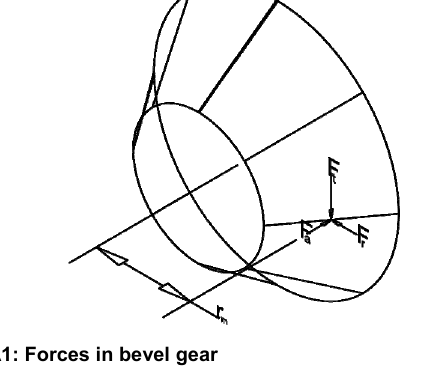
Case II: Right-hand helix and CCW rotation or Left- hand helix and CW